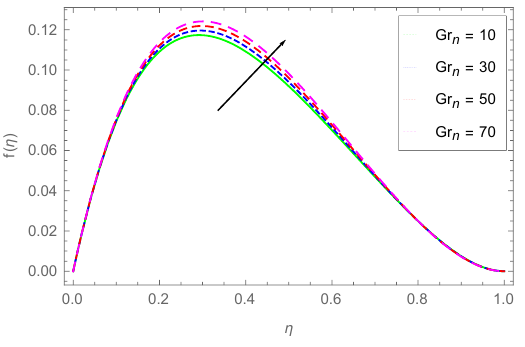
Figure 5. f ( η ) dependence on Gr n . The impact of the enhancing Grashof number Gr n on the velocity gradient f depicted in Figure 6. The values of Gr n chosen were 10, 30, 50, 70. The velocity gradient displays dual behavior with the augmenting Gr n . At smaller η , the velocity gradient profile enhances, whereas at larger η , it drops with the increasing Gr n . The figure also displays that the rate of drop is higher as compared to the rate of enhancement with the increasing Gr n . Thus, the enhancing buoyancy associated with the higher values of Gr n reduces the gradient in the fluid velocity beyond about the mid-point of the boundary layer. Therefore, it is concluded that the increasing buoyancy (decreasing viscosity) associated with higher Gr n does not affect the velocity distribution of the hybrid nanofluid drastically.